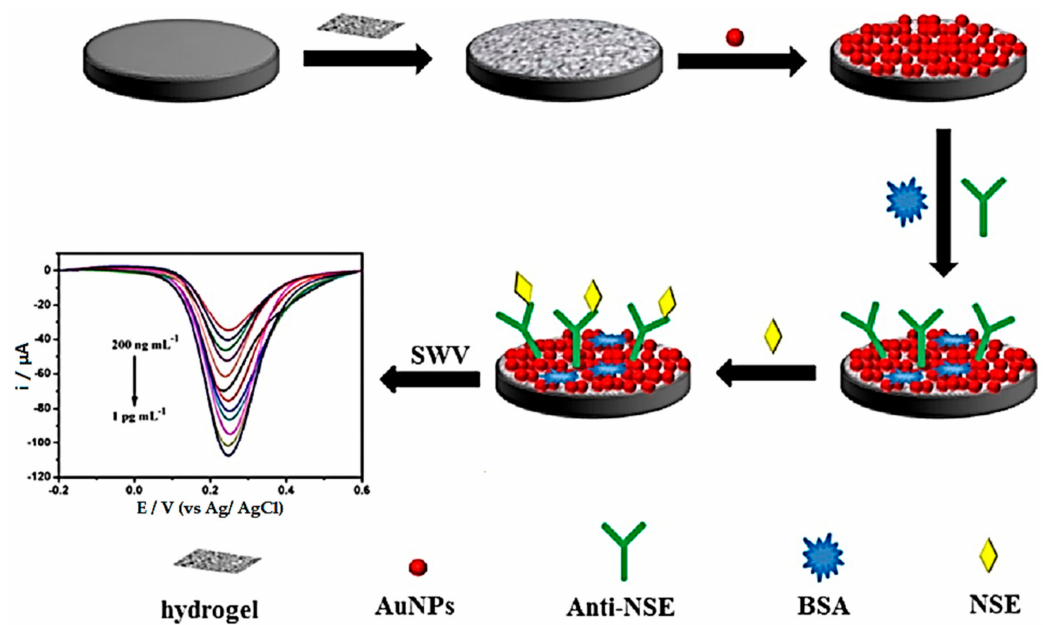
Figure 12. AuNPs electrodeposited conductive hydrogel by adopting a crosslinking method using 1,3,5-benzenetricarboxylic acid as a ligand and Fe3+ as a metal ion was synthesized. The